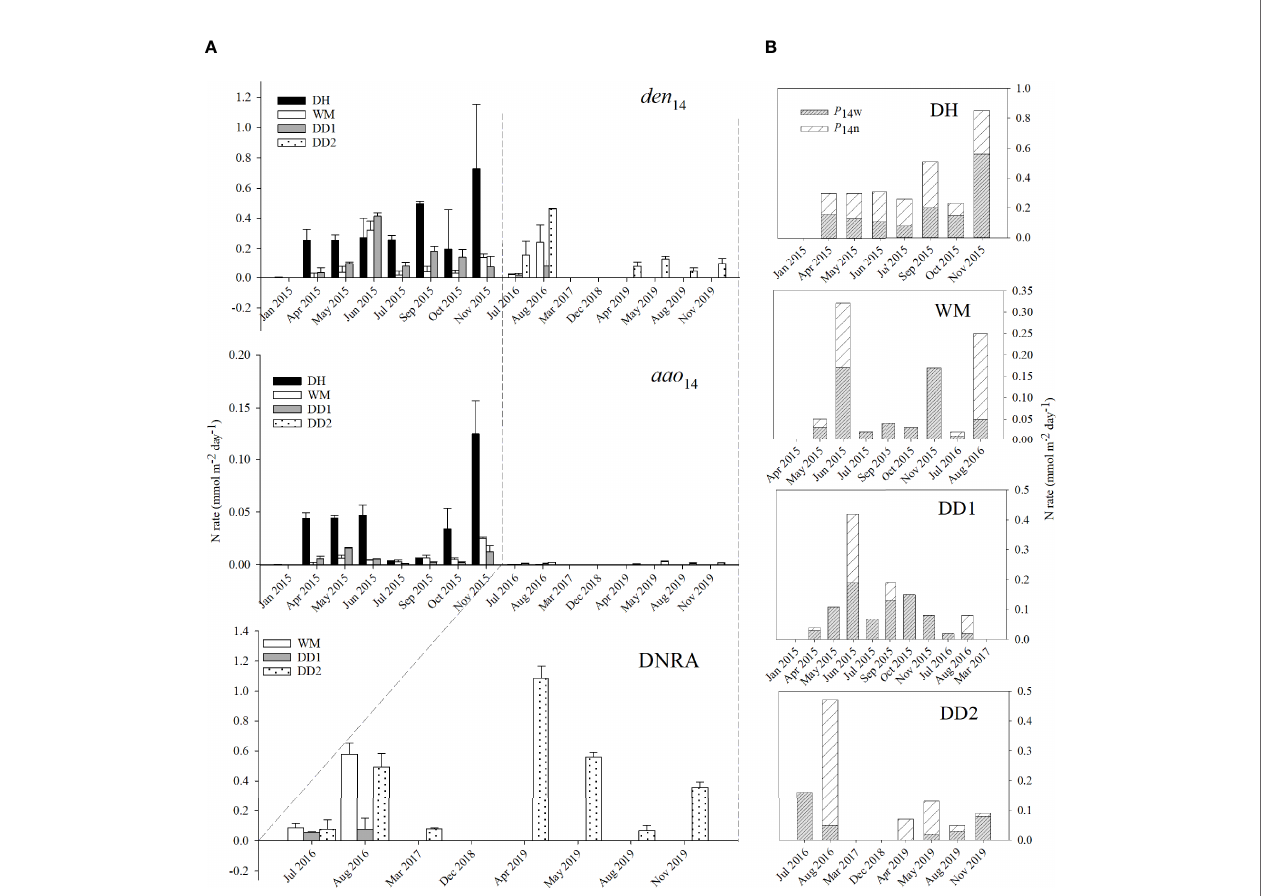
FIGURE 3 | (A) den 14 , aao 14, and DNRA rates among DH, WM, DD1, and DD2 sites in Jinhae Bay from the intact core incubations. Black bars denote DH sites, white bars denote WM sites, grey bars denote DD1 sites, and dotted bars denote DD2 sites. Note that DNRA has a different x-axis (only available from Jul 2016 to Nov 2019). (B) P 14 n (white shaded bars) and P 14 w (grey shaded bars) rates among DH, WM, DD1, and DD2 sites in Jinhae Bay from the intact core incubations. See text for explanation of each